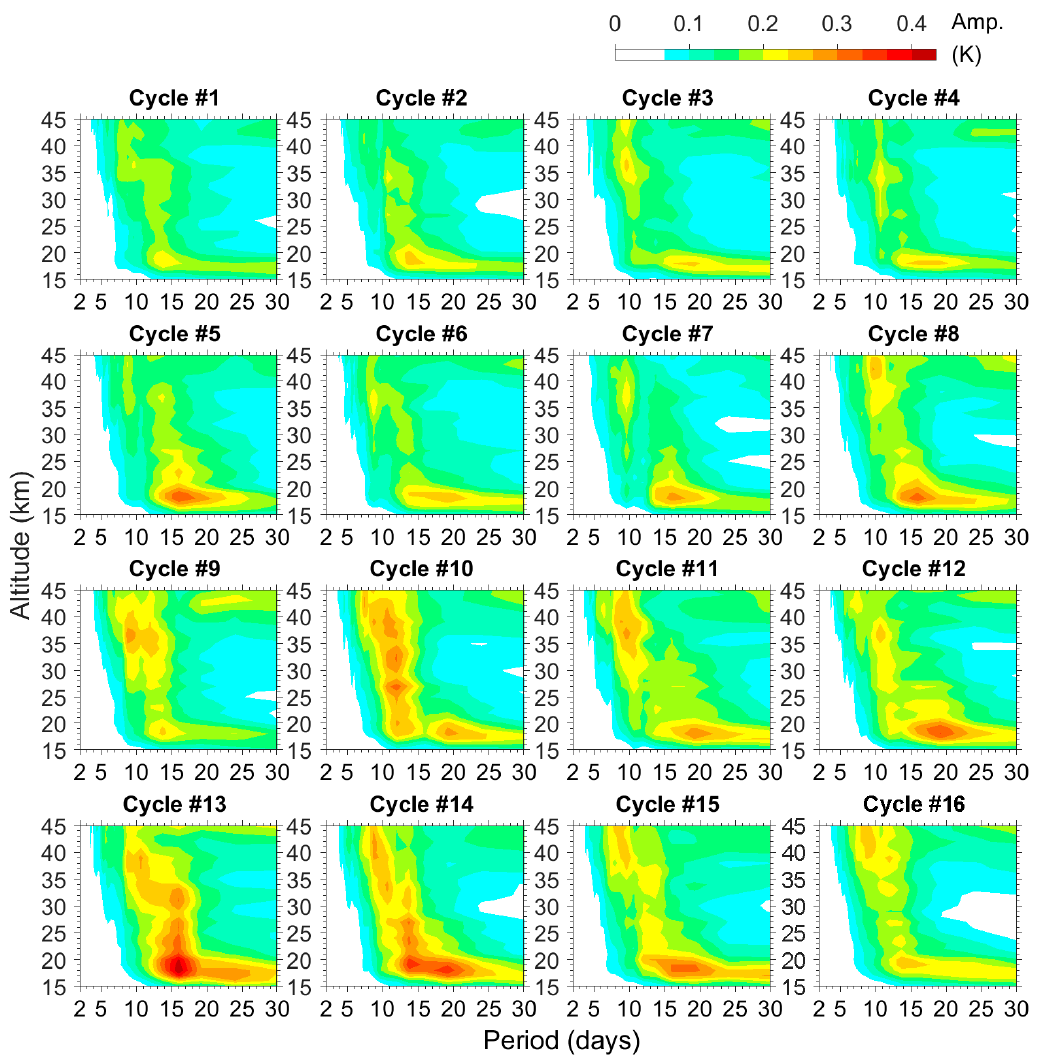
Figure 2. The amplitudes of wavenumber 1 (E1) waves as a function of period and altitude (period–altitude spectra) during different QBO cycles, as defined and indicated in Figure 1.